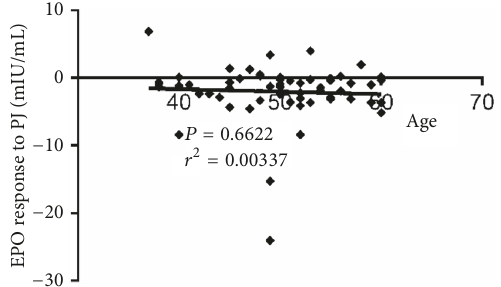
Figure 3: Correlation between the EPO response to PJ and age of patients with T2D (n = 59). P = 0.5354